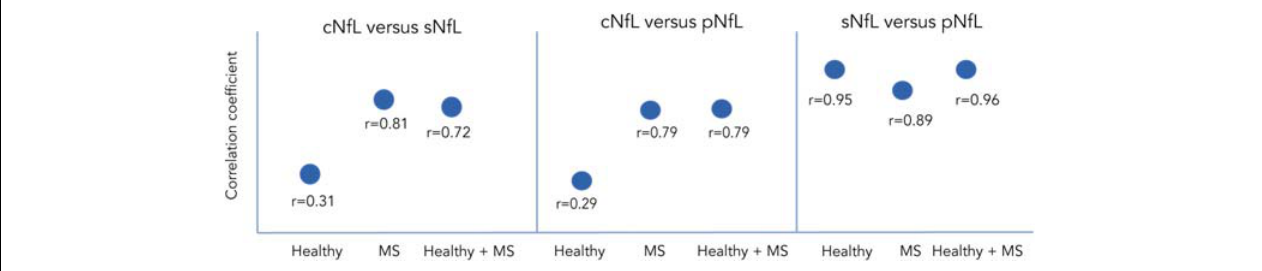
FIGURE 3 | Correlation of NfL between CSF, serum and plasma in different population as reported by Harp et al. (2019), Hendricks et al. (2019), and Sejbaek et al. (2019). Correlation coefficients between NfL measured in CSF vs serum or vs plasma across different populations.